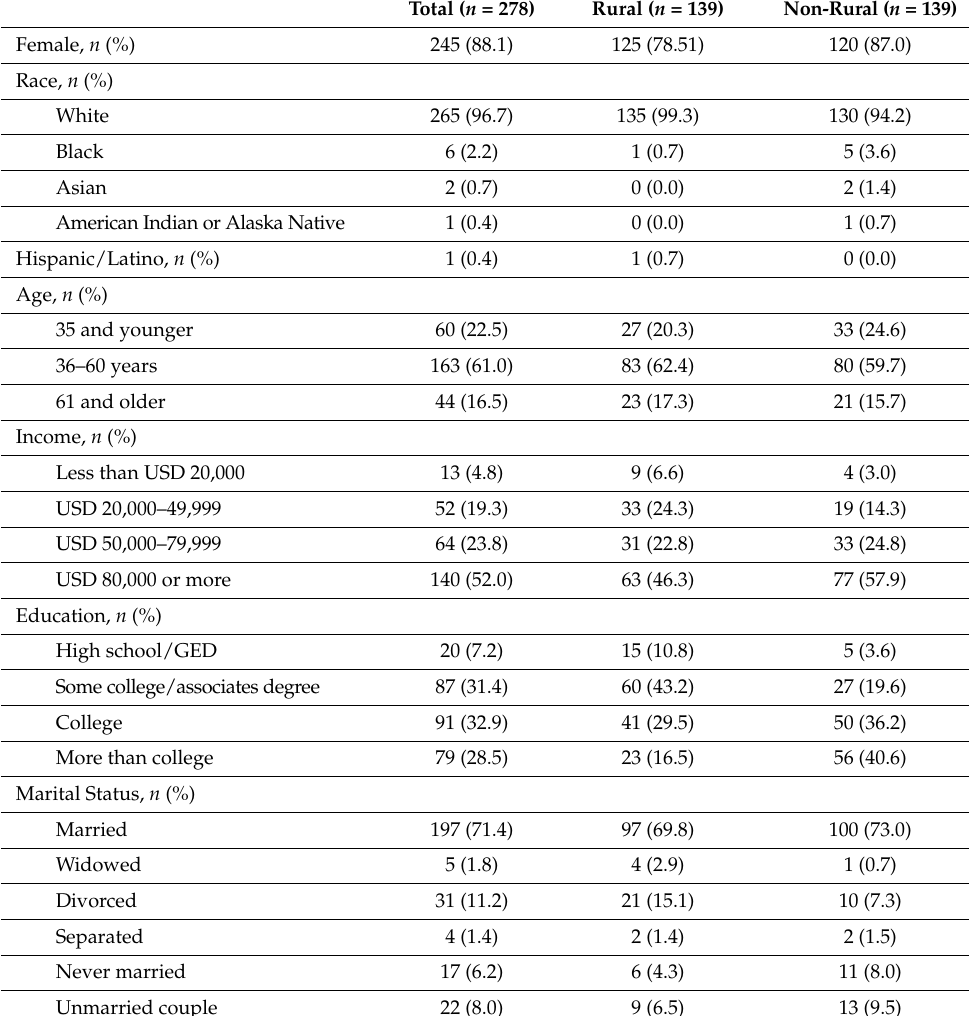
Table 1. Demographic characteristics of rural and non-rural